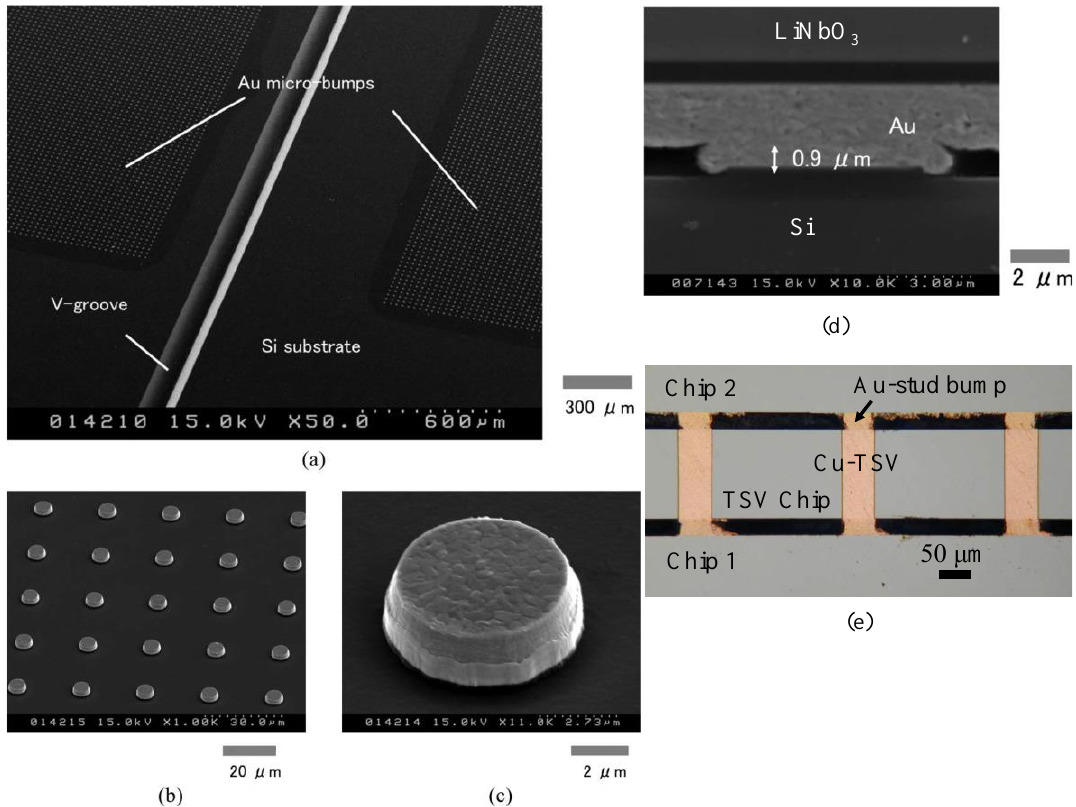
Figure 5. ( a ) SEM image of a Si substrate with a V-groove and Au micro-bumps; ( b ) SEM image of Au micro-bumps; ( c ) Magnification of (b); ( d ) Cross-sectional SEM image of an Au micro-bump on a Si substrate after bonding with a LiNbO 3 substrate [26] (Reproduced with permission from Takigawa et al. , IEEE J. Sel. Top. Quantum Electron. ; published by IEEE, 2011); ( e ) Optical image of cross-sectional view of vertically integrated system between Au-stud bumps and Cu-TSVs [62] (Reproduced with permission from Howlader et al. , J. Vac. Sci. Technol. A ; published by AIP,